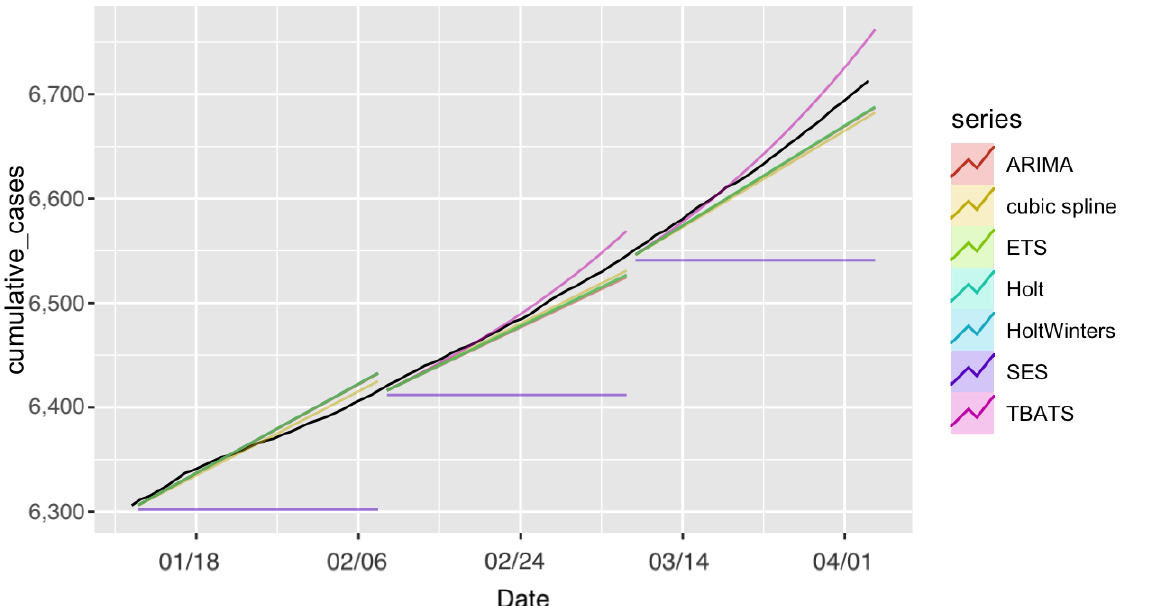
Figure 6. Forecast deaths in Saudi Arabia projected under each model and forecasting period. Black line represents the observed deaths. Table 5. Performance of proposed models to predict KSA deaths. The best accuracy values are shown in bold. Period 1 Period 2 Period